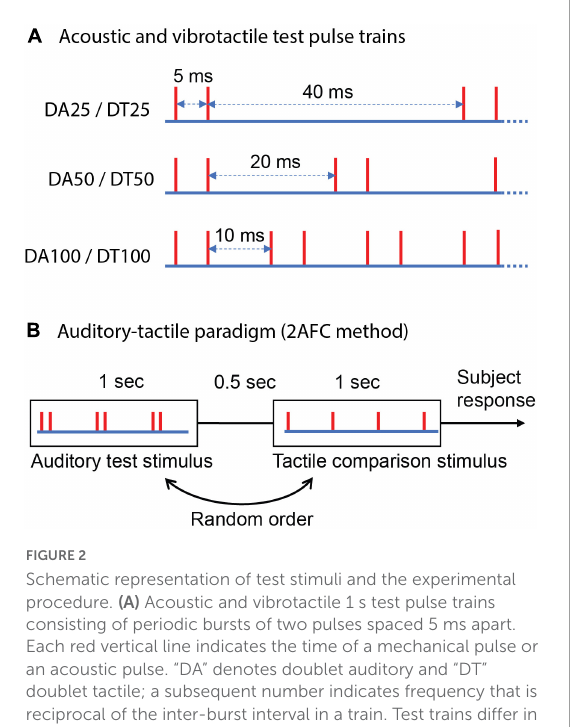
FIGURE2 Schematic representation of test stimuli and the experimental procedure. (A) Acoustic and vibrotactile 1 s test pulse trains consisting of periodic bursts of two pulses spaced 5 ms apart. Each red vertical line indicates the time of a mechanical pulse or an acoustic pulse. “DA” denotes doublet auditory and “DT” doublet tactile; a subsequent number indicates frequency that is reciprocal of the inter-burst interval in a train. Test trains differ in the duration between two consecutive bursts. (B) Two alternative forced-choice (2AFC) method used to estimate cross-modal equivalent frequency, auditory-tactile paradigm is presented as an